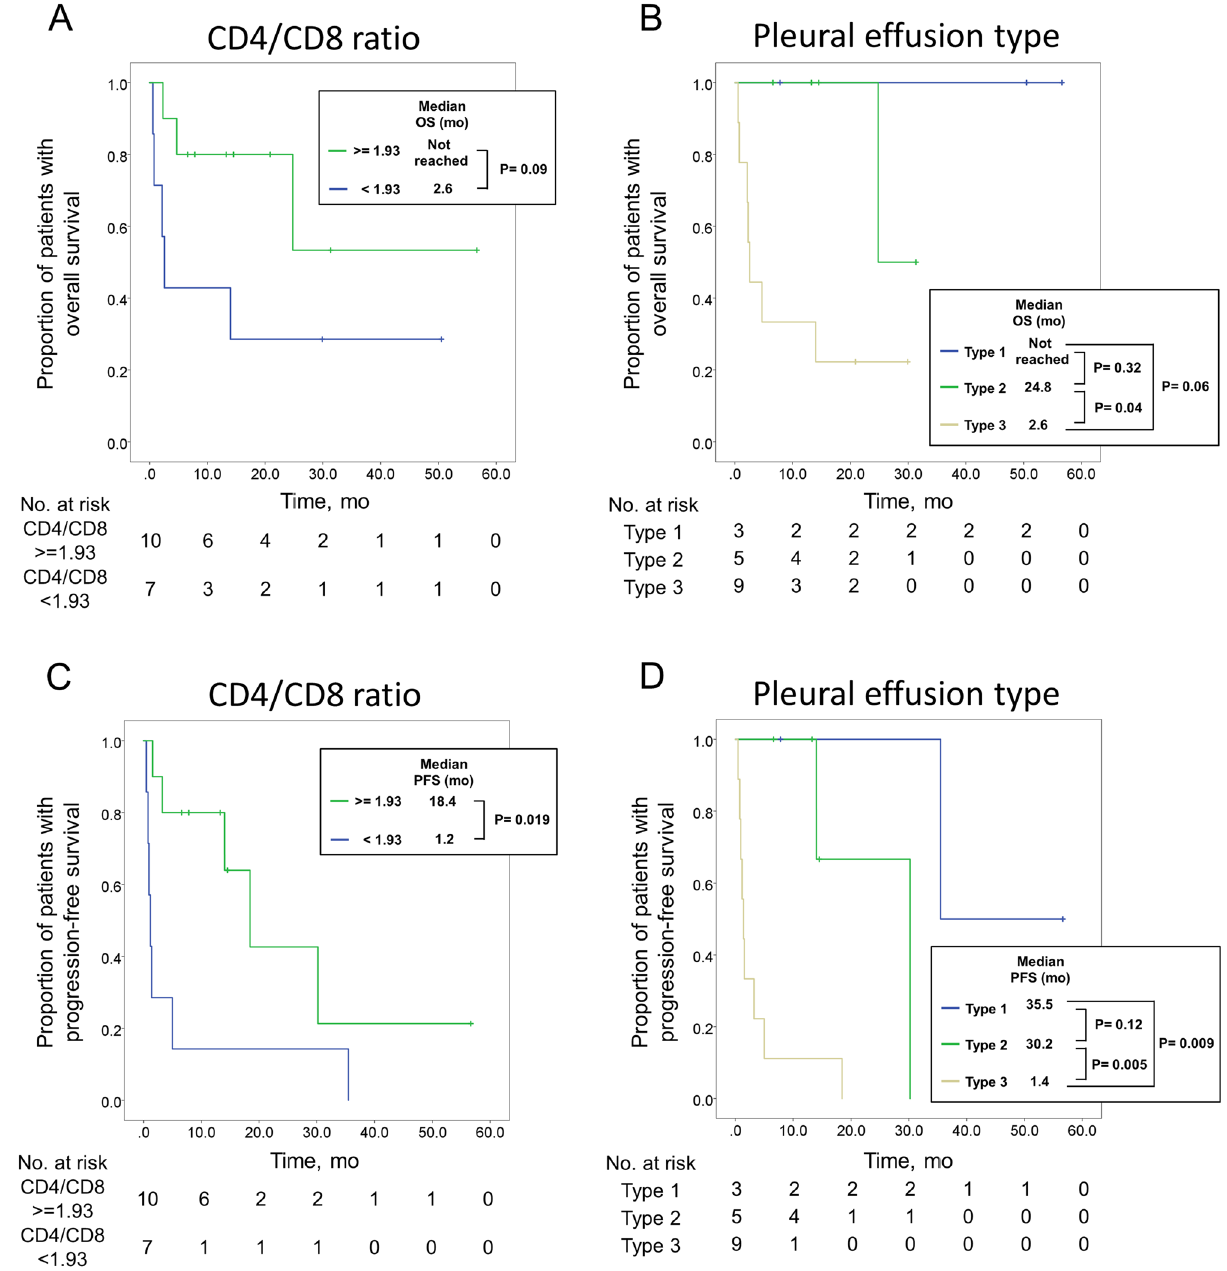
Figure 3. Overall survival (OS) and progression free survival (PFS) according to pleural effusion CD4/CD8 ratios and types. ( A ) OS and ( C ) PFS shown by Kaplan–meier methods according to their different CD4/CD8 ratios in pleural effusion. ( B ) OS and ( D ) PFS plotted by Kaplan–meier methods according to types of pleural Elevated pleural effusion B cell percentages in type 1 patients. Higher percentages of B cells were found in pleural effusions of patients without disease progression, especially in type 1 patients (Table 2). The optimal cutoff percentage of B cells was 6.09% in predicting OS, PFS, and pleural effusion types (online supple- mental Figure 6). In a previous study, Nieto et al. reported CD20+ B lymphocytes account for 5.81% of all leuko- cytes in malignant pleural effusion 12 so our finding of 6.09% is reasonable for defining an “elevated” B cell ratio. Of the 17 patients, 5 had elevated B cell ratios in their initial pleural effusion analyses, and 4 of them were with type 1 and type 2 effusions. Furthermore, high CD4/CD8 ratios also correlated with elevated B cell ratios (online supplemental Table 3). The B cell proportions of each patient are shown in online supplemental Figure 3D; while the proportions divided by type 1/2 and type 3 are shown in online supplemental Figure 3F.